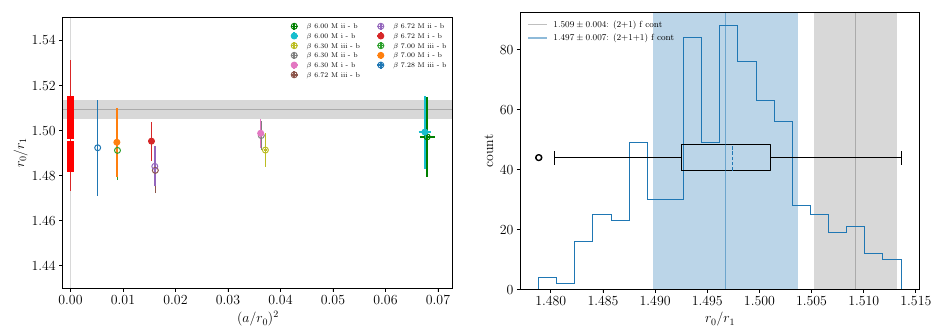
Figure 2. Left: Continuum results ( □ ) and smoothened data ( ◦ ) for the ratio r 0 /r 1 using bare links. Right: Histogram of the continuum extrapolations for the ratios r 0 /r 1 from the left side. The gray bands indicate the (2 + 1)-flavor QCD value